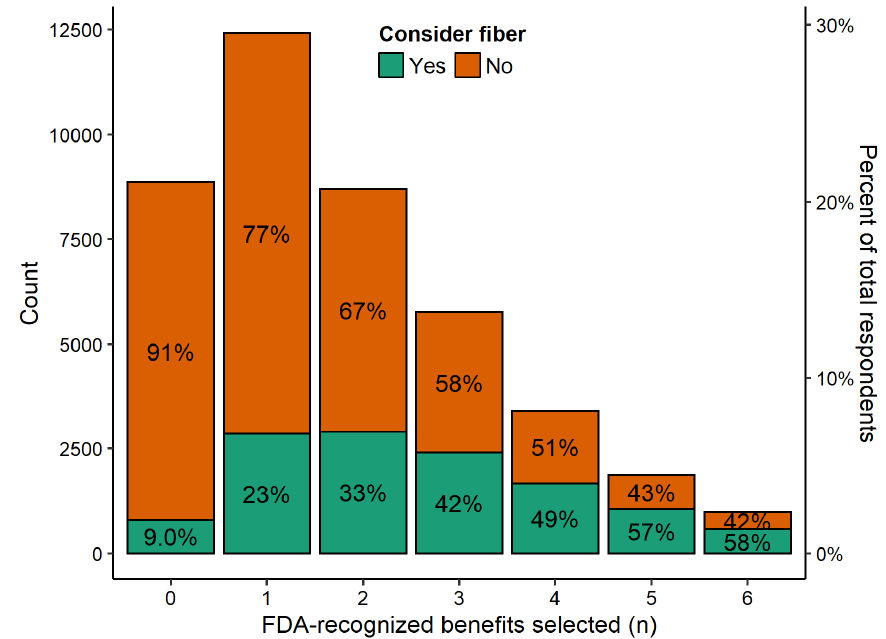
Figure 2. Distribution of the number of FDA-recognized health benefits selected by participants in the IRi survey; bars are colored by whether participants indicated they consider fiber when making food choices; percentages within bars are the proportion of individuals selecting the given number of FDA-recognized benefits that considered or did not consider fiber when making food choices; the percentage of respondents given on the right y -axis is the proportion of the entire sample that selected the given number of FDA-recognized benefits.